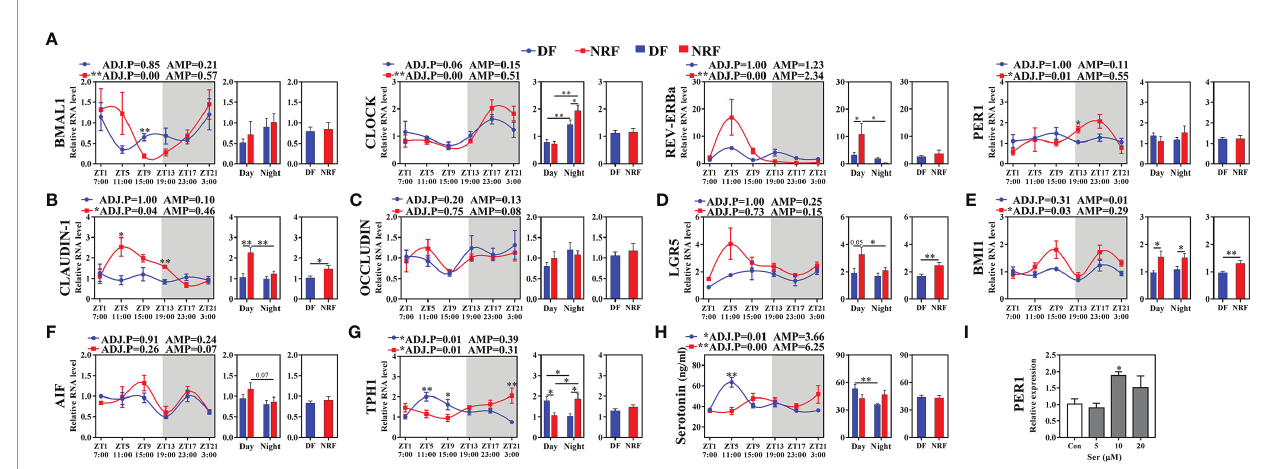
FIGURE 5 | Effects of feeding time on the expression of clock and clock-controlled genes in cecum of growing rabbits (n = 6 per time point). (A) The expression of clock genes. (B, C) Tight junction genes. (D – F) Intestinal epithelial cells regeneration and apoptosis genes. (G, H) Serotonin synthesis rate-limiting enzyme TPH1 genes expression and the diurnal rhythm of serotonin in serum. White boxes indicate daytime and gray boxes indicate nighttime. (I) Expression of PER1 gene in rabbit intestinal epithelial cells induced by serotonin. ADJ.P for adjusted minimal p -values, ADJ.P < 0.05 indicates signi fi cant diurnal rhythm, AMP represents amplitude, *ADJ.P < 0.05; **ADJ.P < 0.01. Differences between the DF and NRF groups were determined with a t-test, * p < 0.05; ** p < 0.01. DF, daytime feeding; NRF, night-restricted feeding. Data are shown as the mean ±